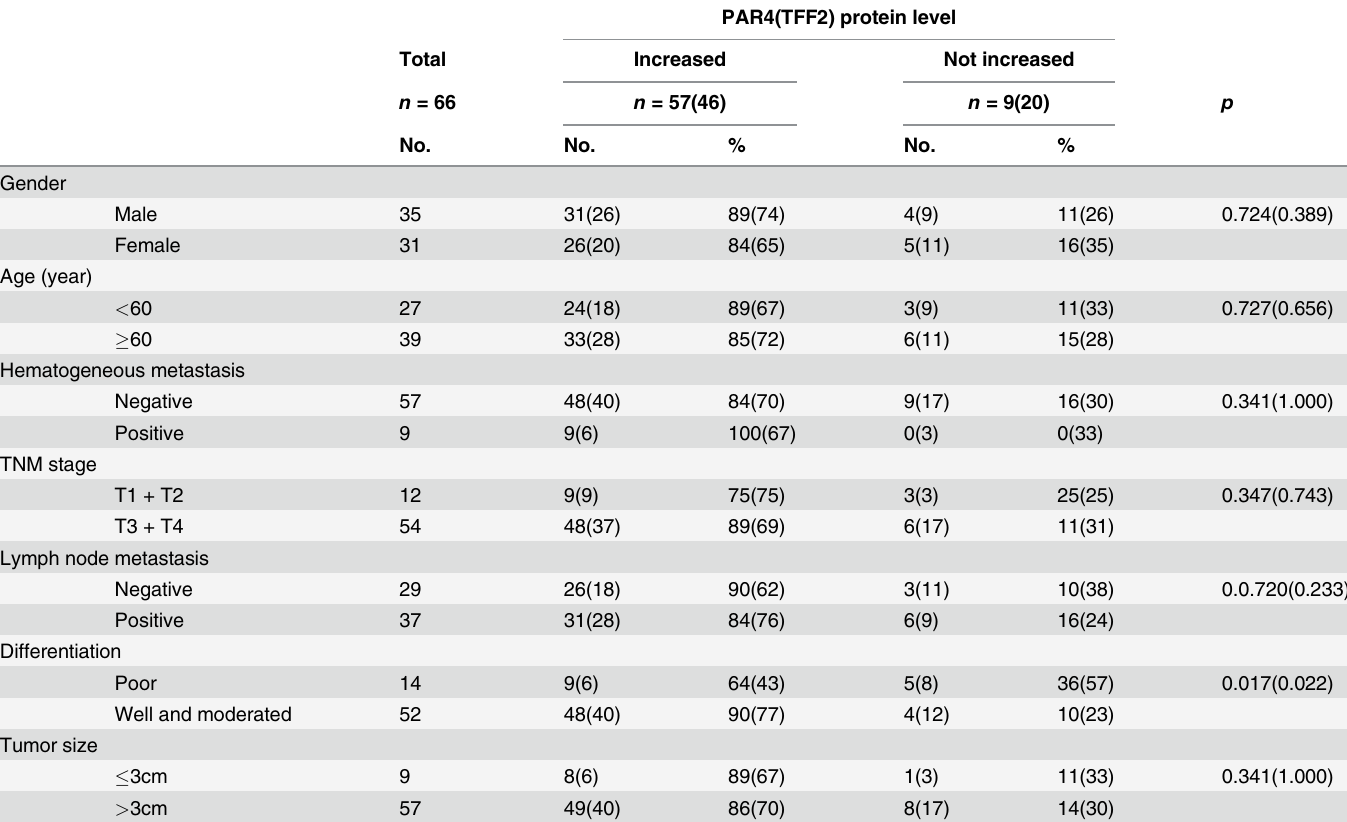
Table 2. Association between the protein levels of PAR4 and TFF2 with clinic-pathological data of colorectal